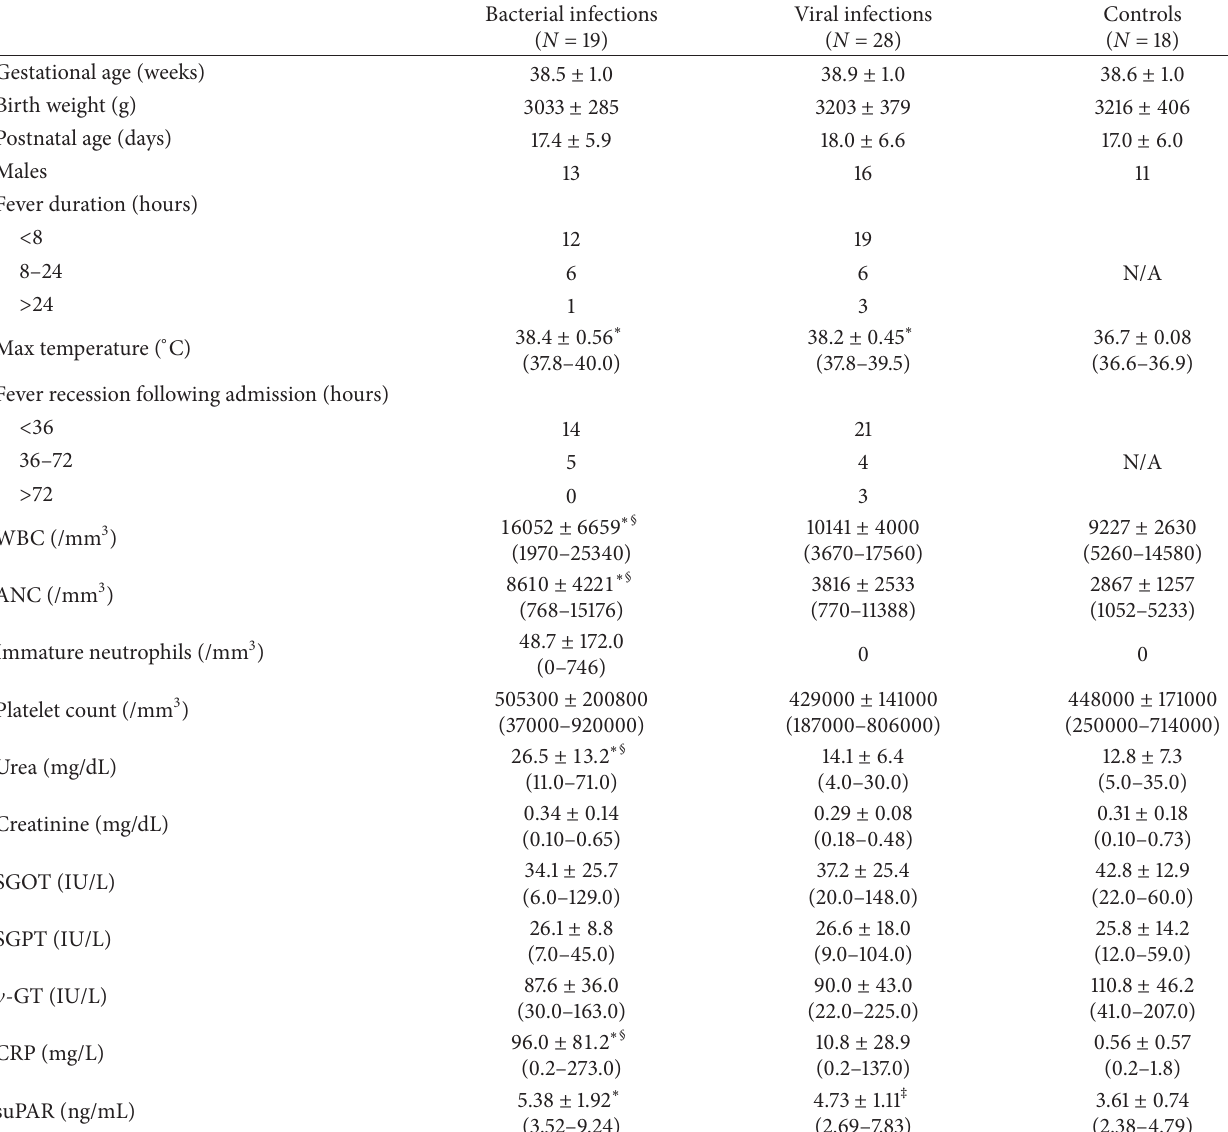
Table 2: Demographic, clinical characteristics, and laboratory findings in infants with bacterial and viral infections on admission to the Unit and in